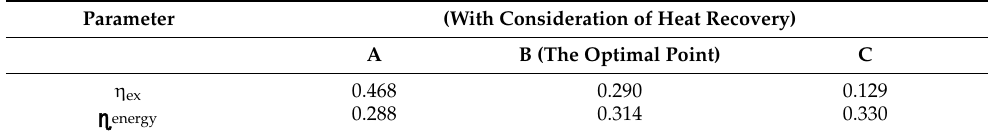
Table 4. The optimal exergy and energy efficiency values for points A, B, and C at suitable Pareto parameters for the given inputs.